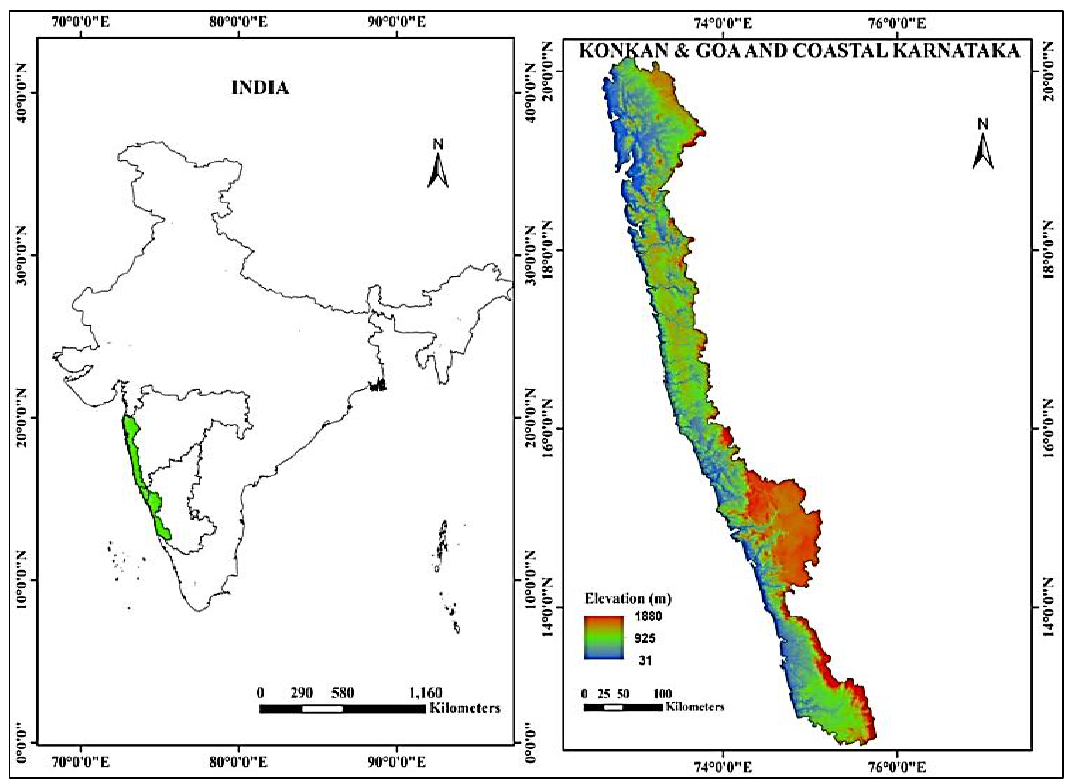
Figure 1. Location Map of the study